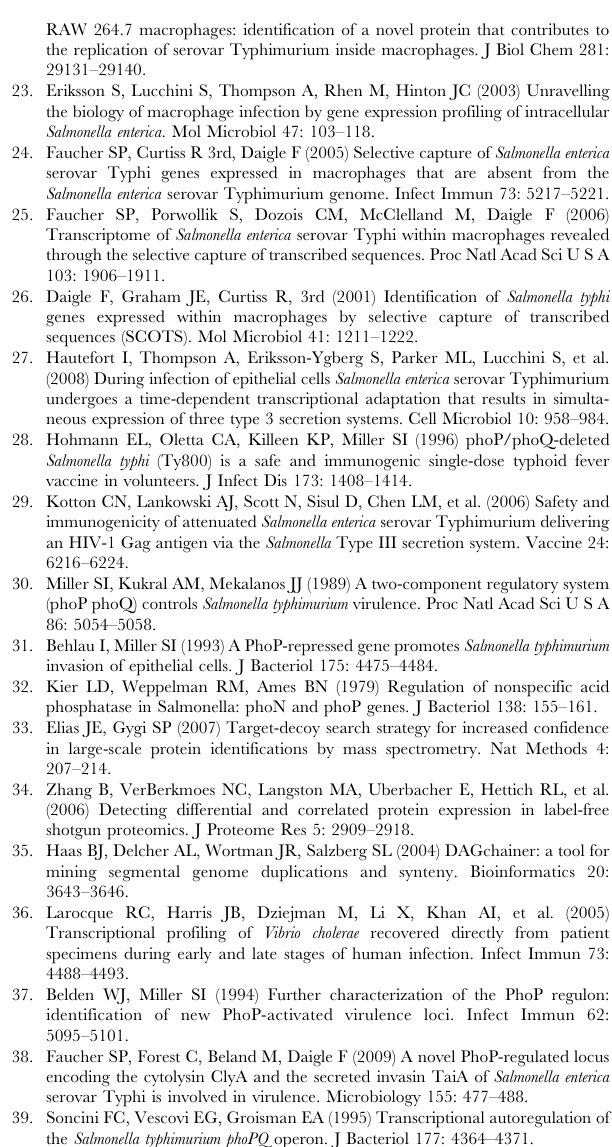
Table S3 PhoP-repressed proteins identified in both S. Typhi and S. Typhimurium. List of PhoP-repressed proteins identified in our analysis in both S. Typhi and S.